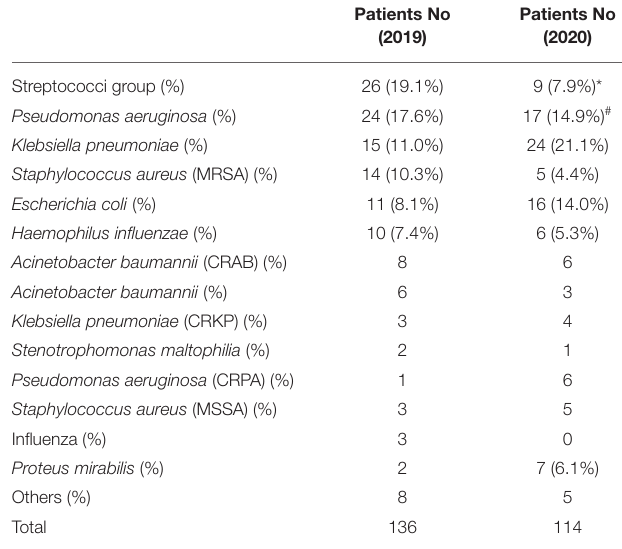
TABLE 1 | Community-acquired pneumonia patients requiring hospitalization, by season and age cohorts.